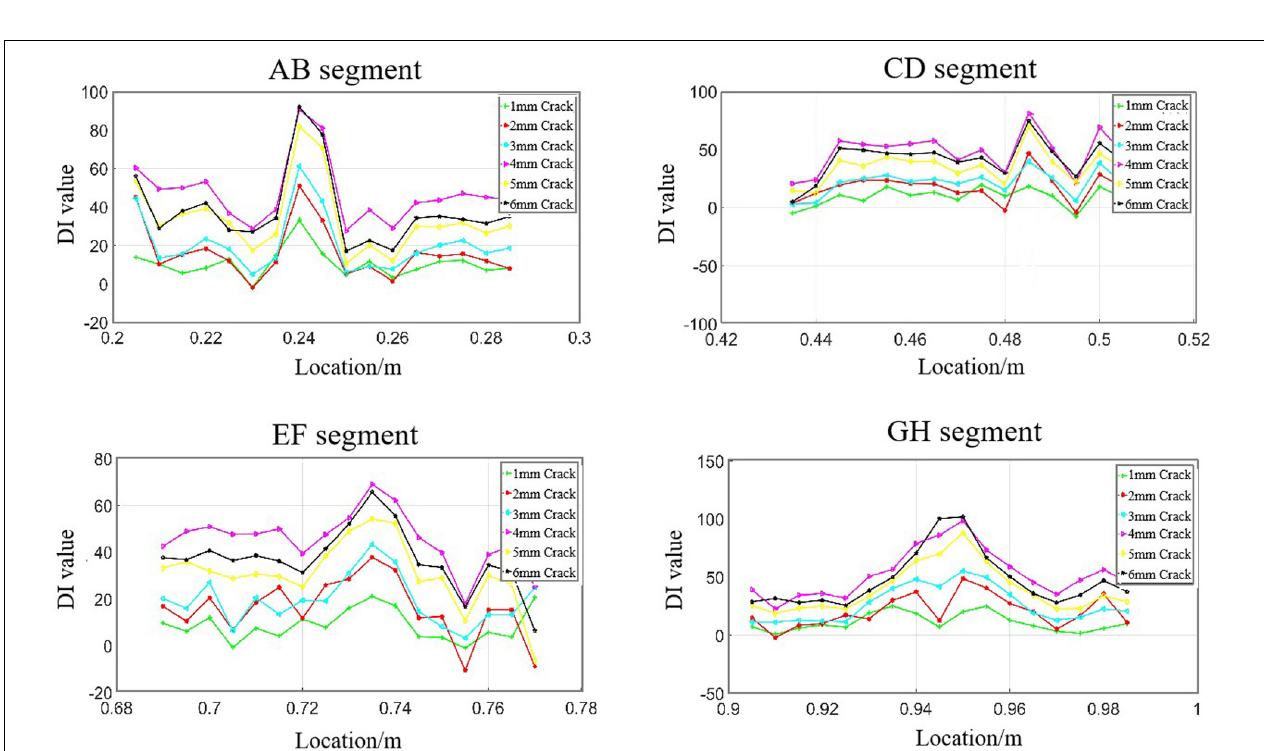
FIGURE 10 | The DI changes of distributed optical fiber signal segments (AB, CD, EF, GH) with crack growth.